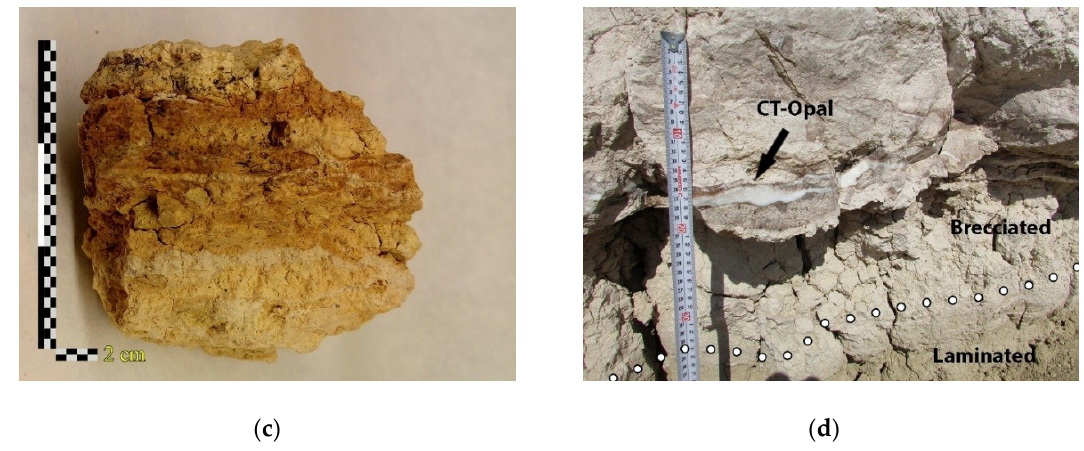
Figure 5. Outcrop and hand-sample views of lithofacies: ( a ) lithofacies I.1-A composed of massive claystones with common slickensides; ( b ) close-up view of the boundary between I.2-A and I.2-B lithofacies; ( c ) hand-sample from lithofacies I.2-A showing conspicuous lamination and various colors; and ( d ) detail of opal-CT occurrences locally associated to Mg-clay lithofacies.